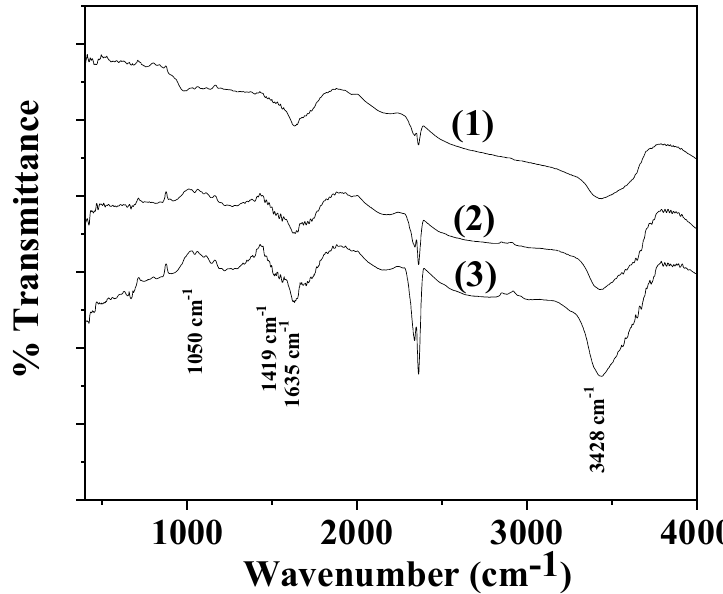
Figure 5. Representative FTIR spectra of (1) ALG/G, (2) ALG/G/NZ, (3) ALG/G/TO@NZ obtained films.